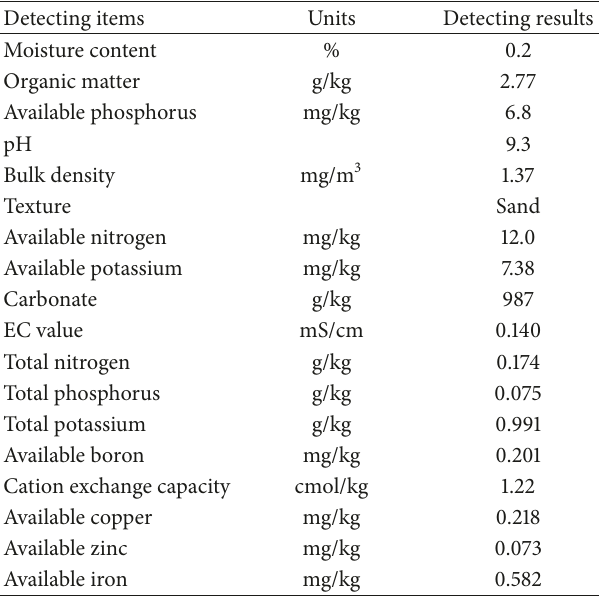
Table 2: The properties testing table of coral aggregate in